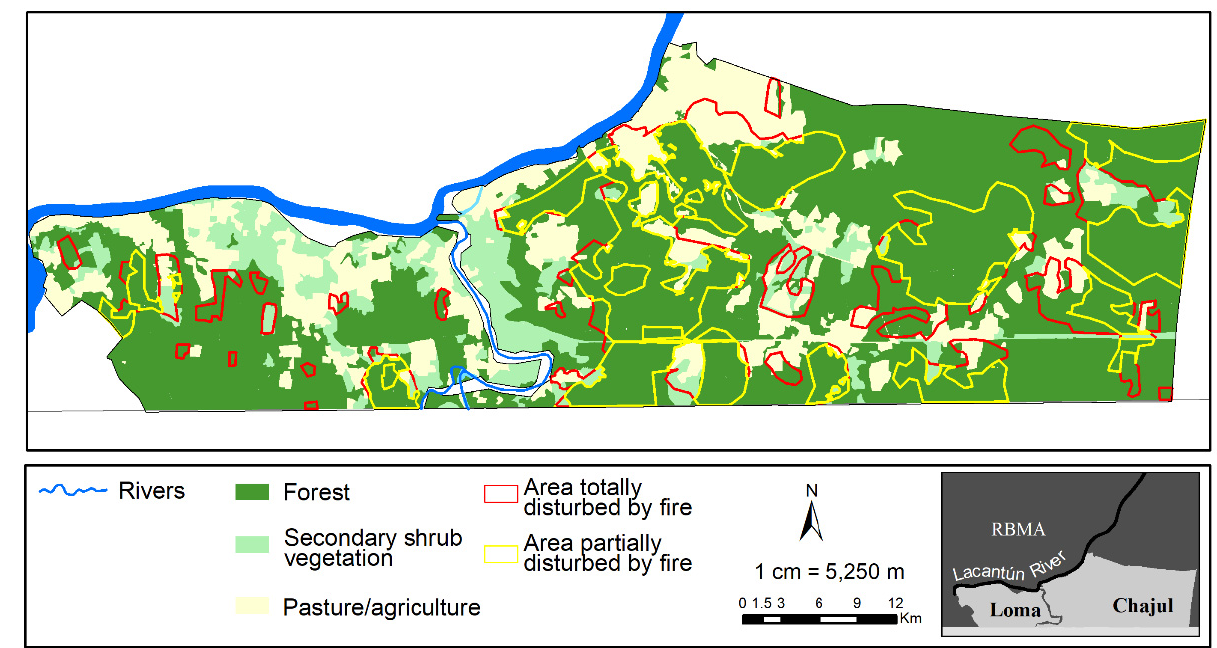
Figure 6. Map showing the areas affected by the 1998 fire in the study area . Source: rivers [24]; ejido limits [26].